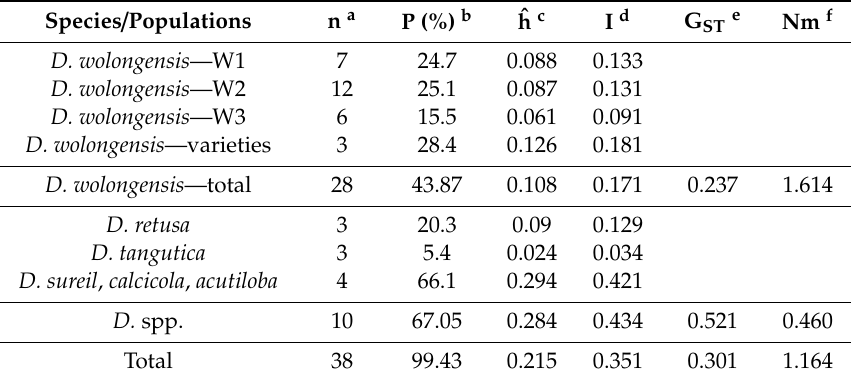
Table 2. Diversity characteristics of three Daphne wolongensis local populations, Daphne wolongensis varieties, and another Daphne species based on AFLP analysis.